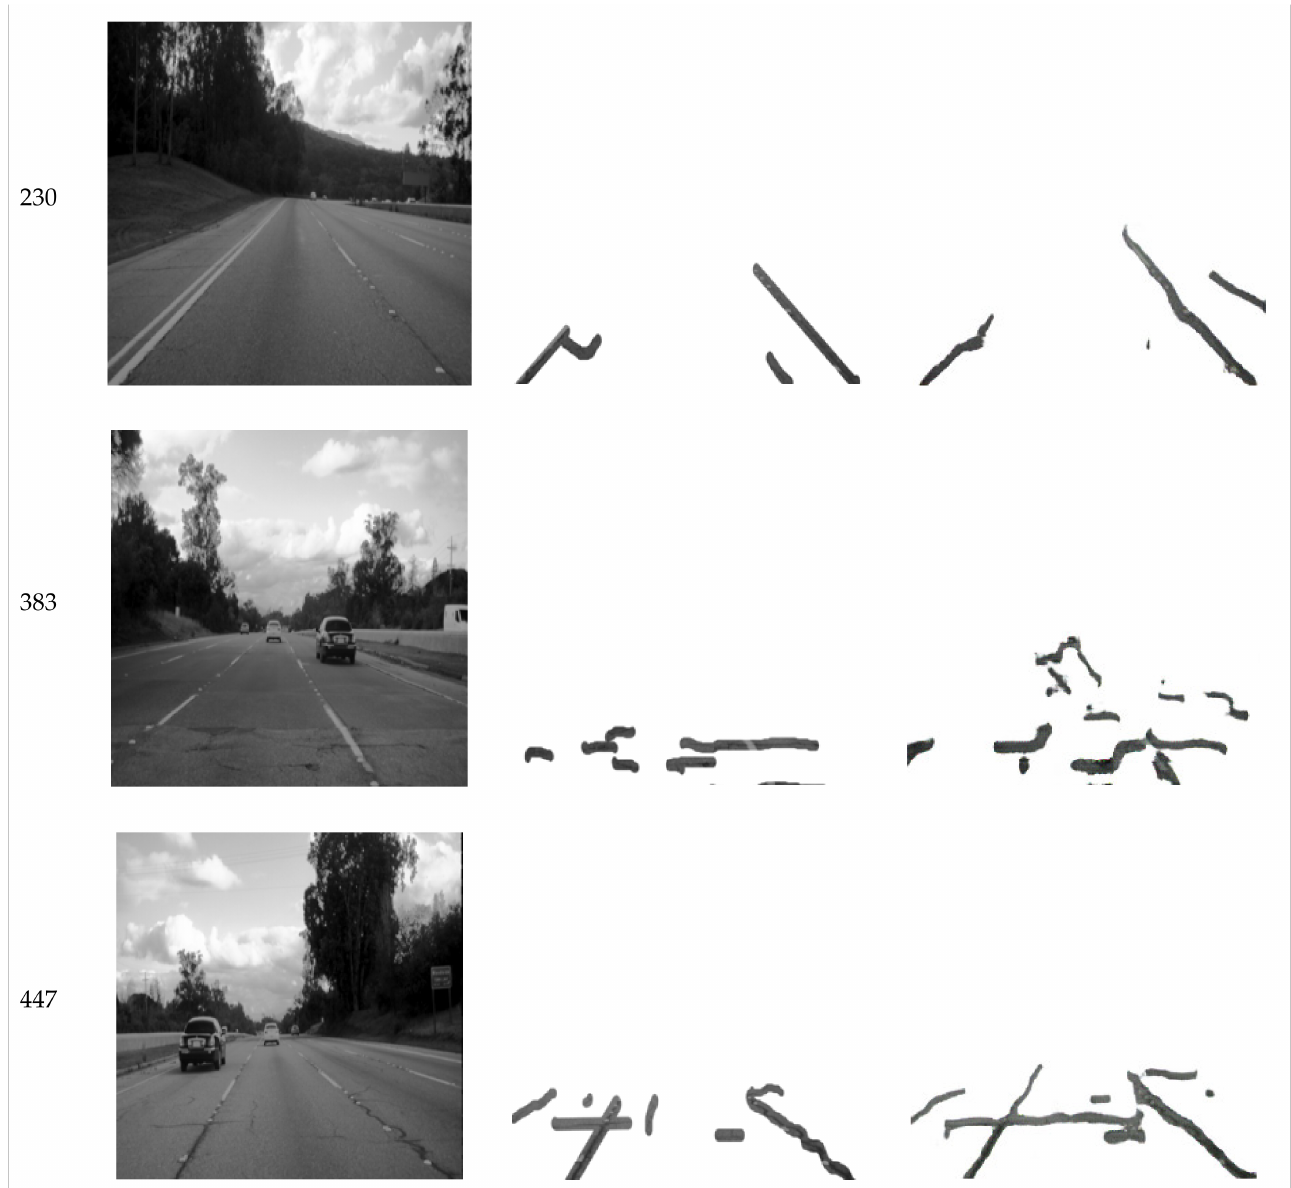
Figure 4. Images showing the results of our improved